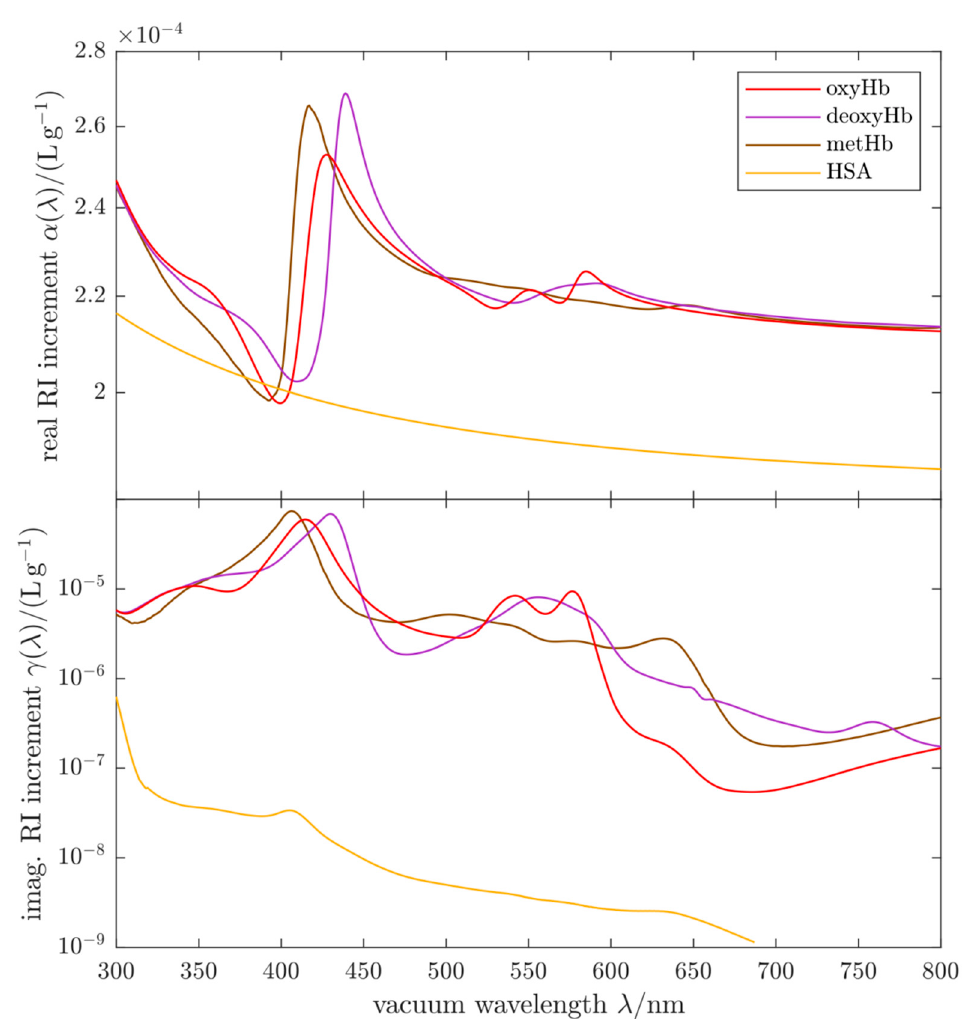
Figure 5. Complex refractive index increments of the Hb components and HSA used in our calculations of the extinction cross sections of HbMPs.